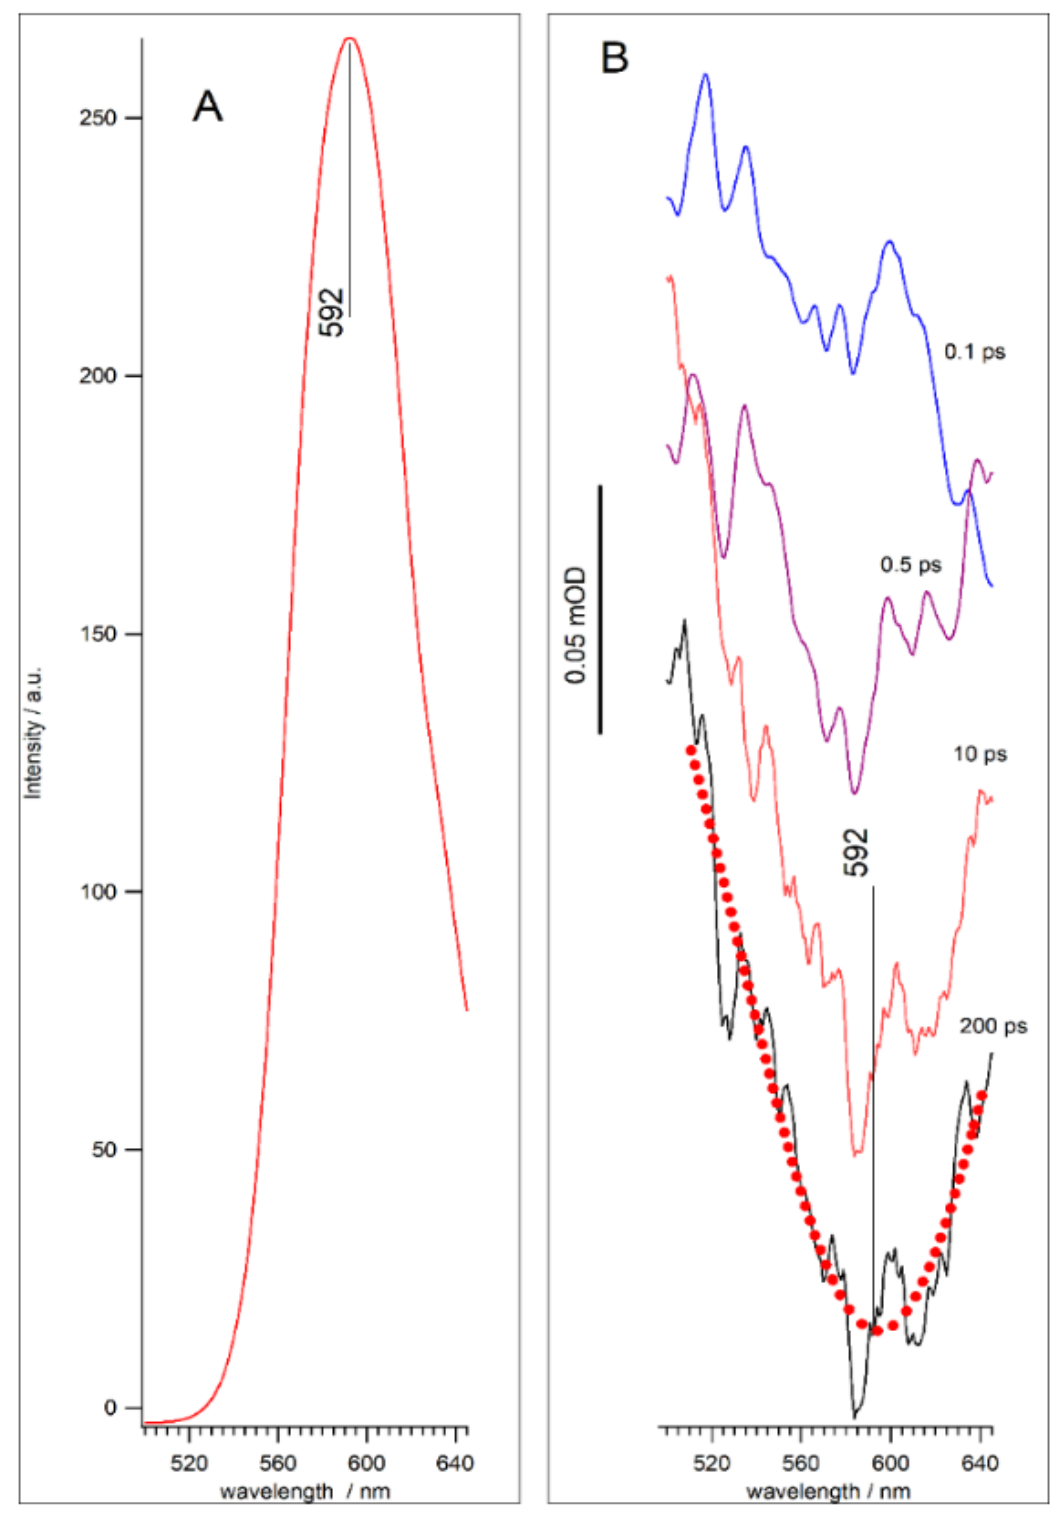
Figure 5. Mn 2+ PL band ( A ) and transient spectra of QD-2 sample at different delay times ( B ). Red dotted line is Gaussian fitting curve.